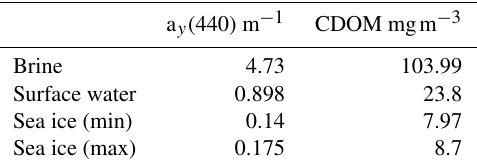
Figure 6. Linear regression between CDOM absorption at 440nm and CDOM content derived from Wetlabs CDOM fluorescence sen- sor. Table 3. CDOM absorption and CDOM concentration in brine, wa- ter, and sea ice at station